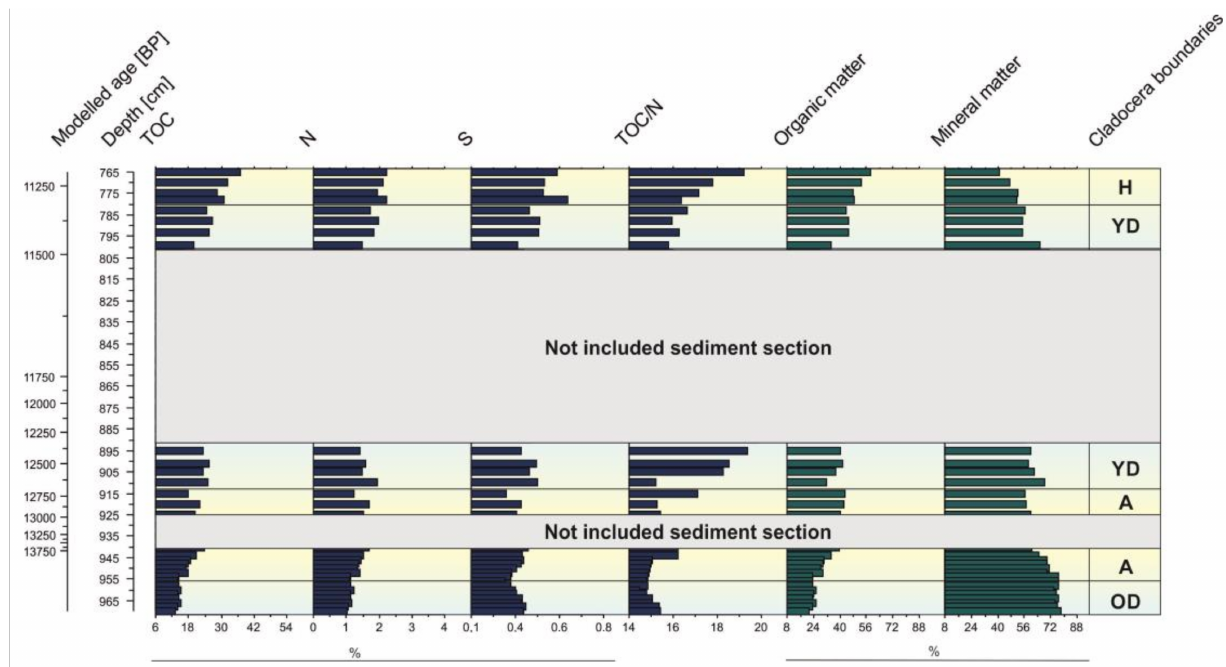
Figure 6. Basic geochemical parameters determined for the core Z-3. Abbreviations: OD = Older Dryas, A = Alleröd; YD = Younger Dryas; H =